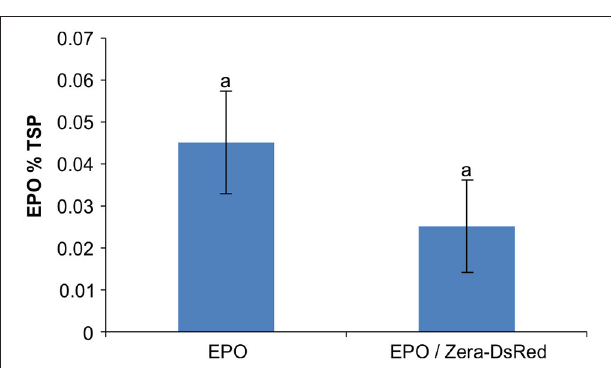
FIGURE 2 | Co-expression of erythropoietin and Zera-DsRed. Enzyme-linked immunosorbent assay (ELISA) of recombinant EPO was used for quantification of EPO in agroinfiltrated N. benthamiana leaves. Each column represents the mean value of 4 biological replicates collected at 4-dpi. Columns denoted with the same letter were not significantly different ( p < 0.05) using one-way ANOVA. The error bars represent the standard deviation of the